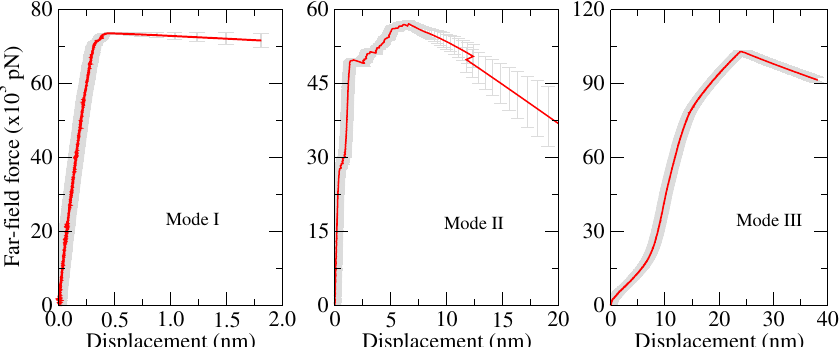
Figure 10. Force vs. displacement trajectories for the aragonite tablet models for Mode I, II and III. The red line represents the averaged curve related the different starting structures in MD simulations, and the gray shaded area is related to the standard error deviation.